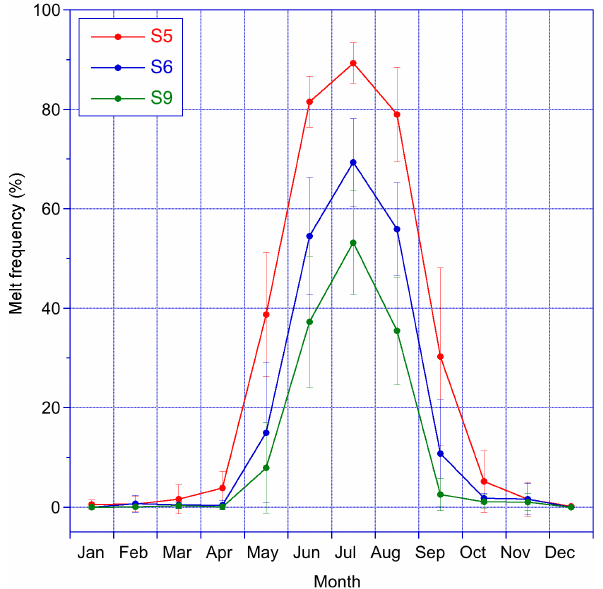
Fig. 5. Average seasonal cycle of melt frequency, based on hourly data, at S5 (red line), S6 (blue line) and S9 (green line). Error bars indicate standard deviation for the 7-yr period.